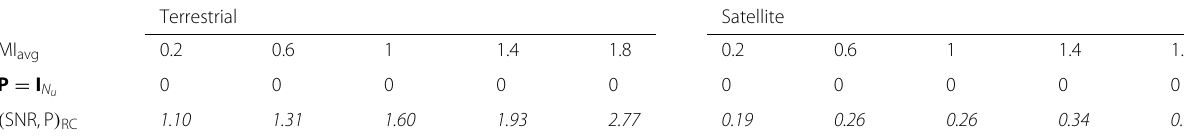
Table 8 SNR gain (dB) of the CD for 4-QAM Terrestrial Satellite